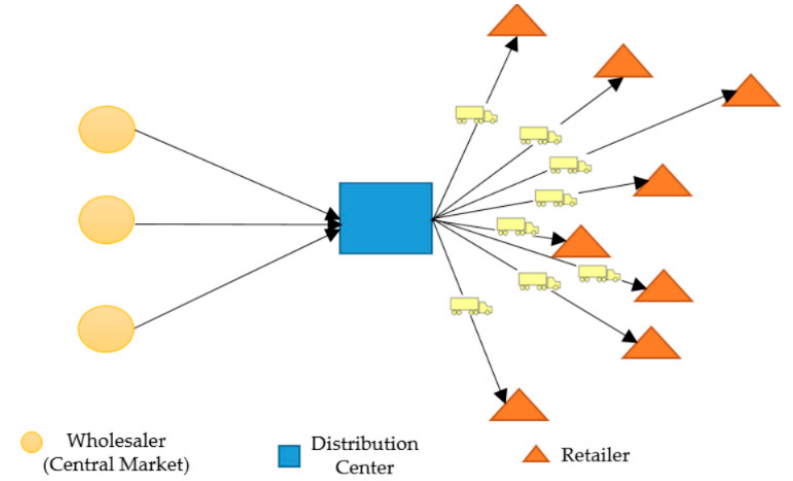
Figure 5. The transport network of scenario 1 (AS IS).